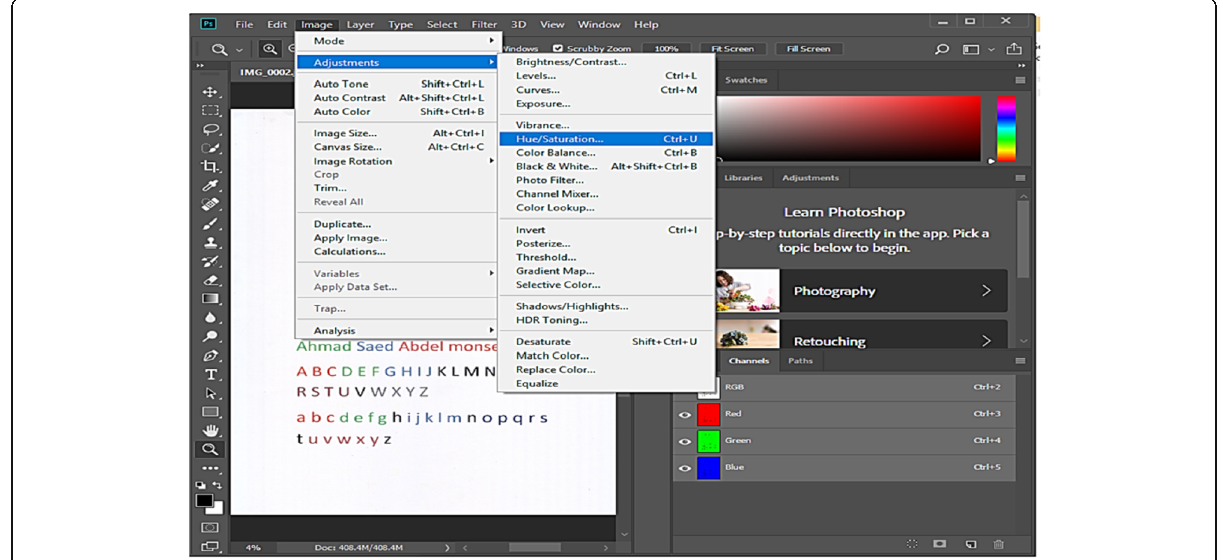
Fig. 4 The HSL colors combined system selected in Adobe® Photoshop® CC 2018 for adjustments